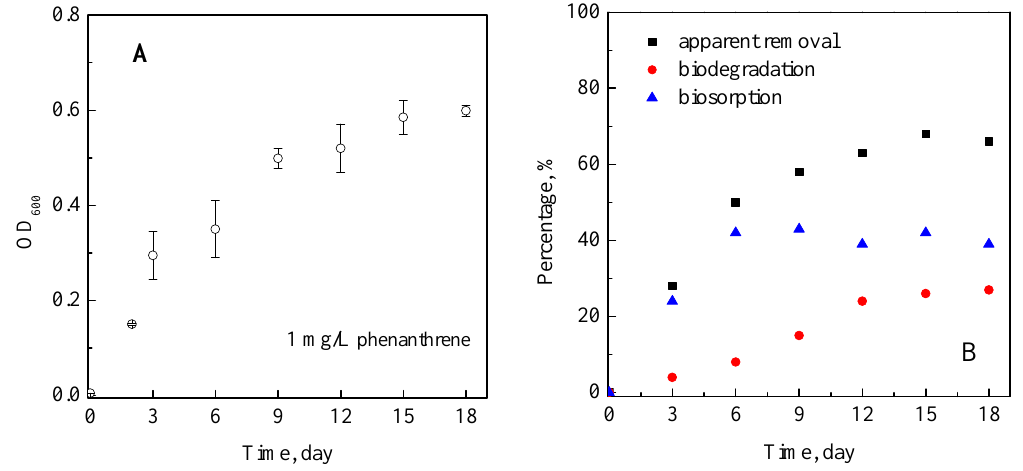
Figure 2. The growth of Klebsiella oxytoca with phenanthrene as the sole carbon source ( A ) and the transportation of phenanthrene in water–bacteria system ( B ).